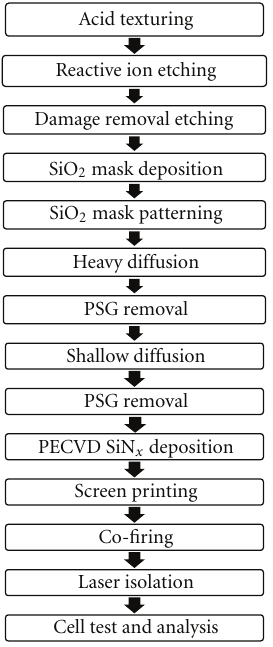
Figure 1: Fabrication process for screen-printed selective emitter mc-Si solar cells with RIE